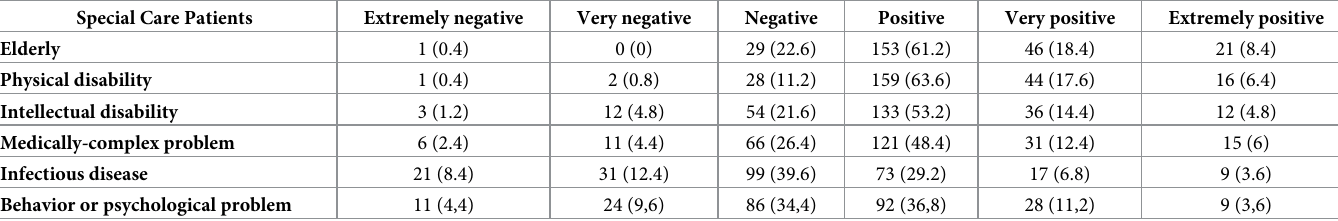
Table 3. Distribution of respondents’ perception of feel towards special care patients (N, %). Special Care